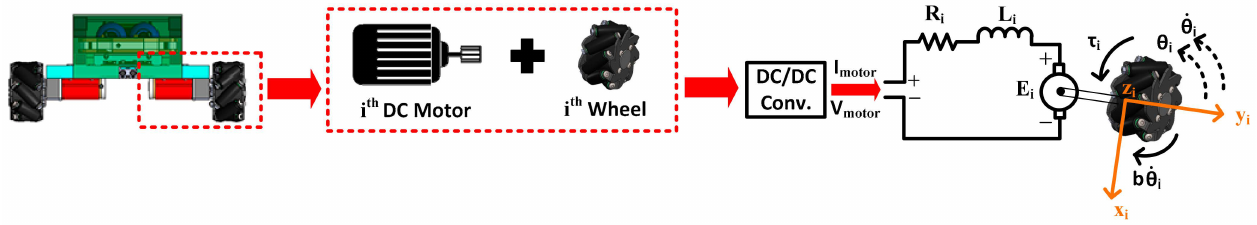
Figure 3. Schematic diagram of ith DC